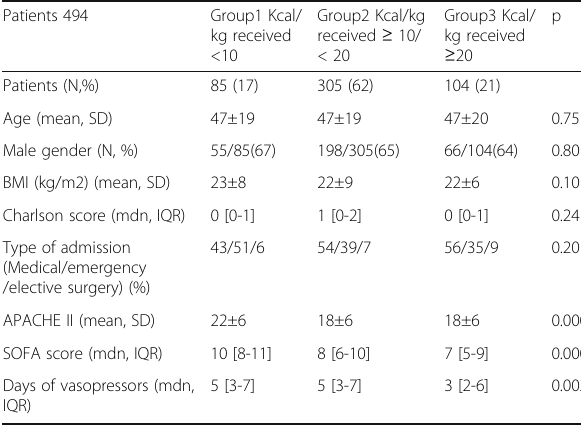
Table 1 (abstract 0042). Characteristics of the 3 subgroups of patients on